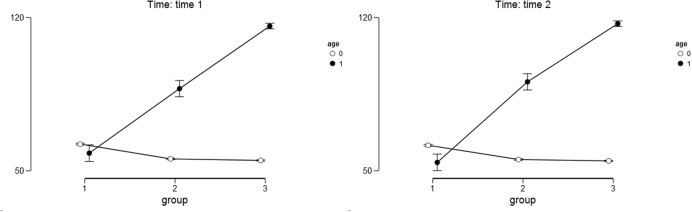
Descriptive statistics for meaning of life as the outcome variable. Age – 0 stands for younger children and 1 stands for older children. Group – 1 stands for control group; 2 stands for placebo group; 3 stands for narrative group. Error bars represent the 95% confidence interval (CI) of a mean.